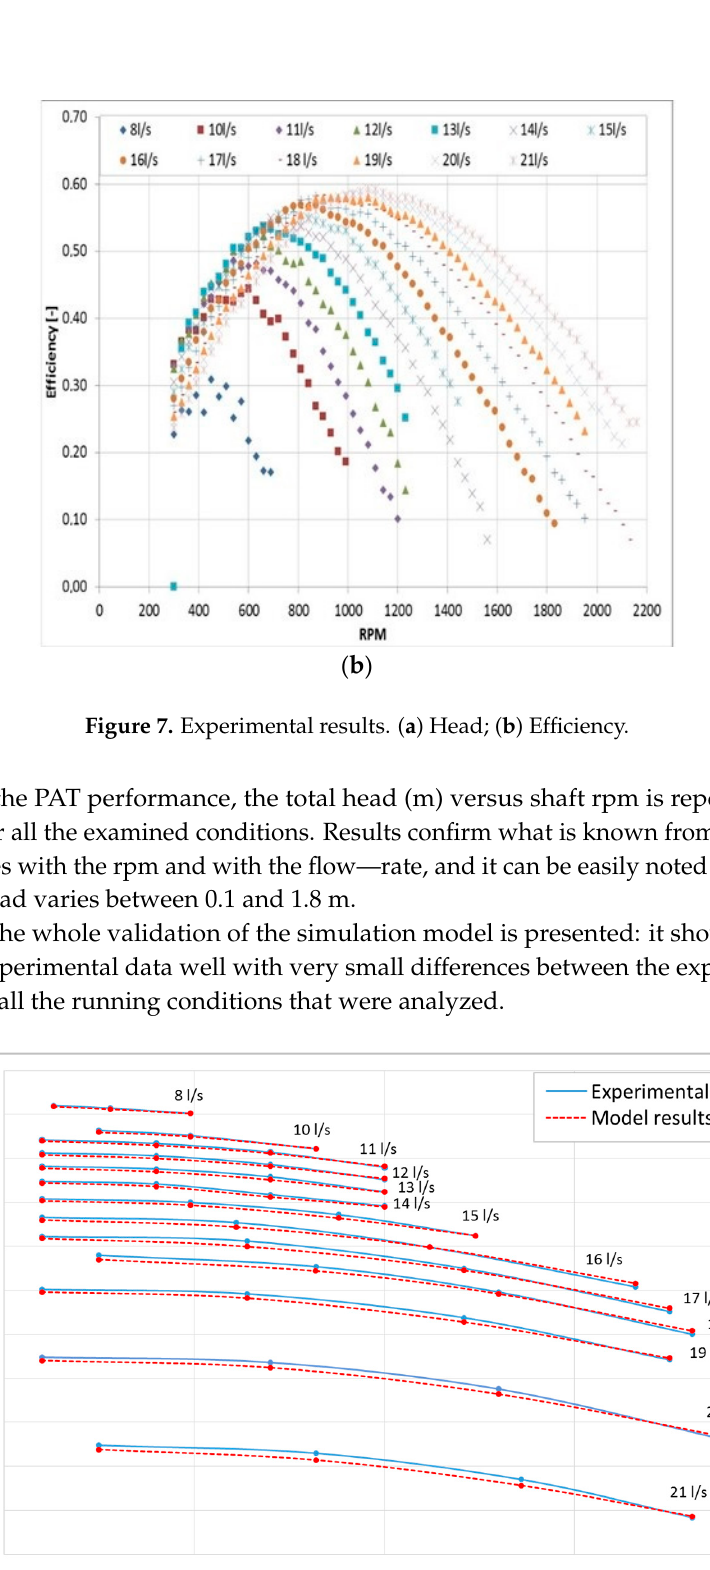
Figure 8. Model validation.